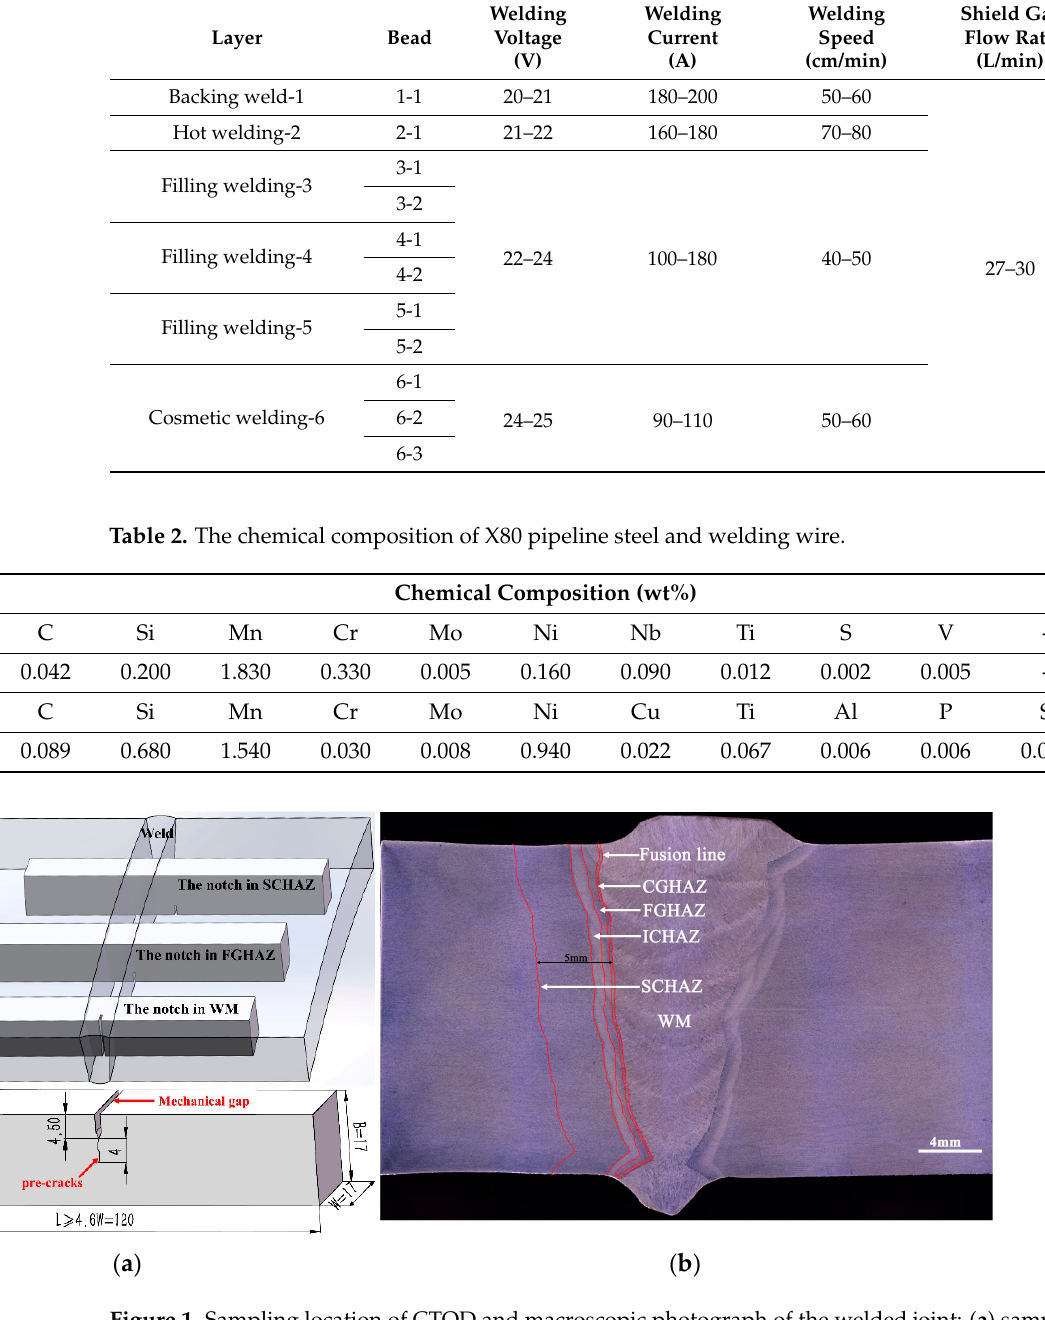
( c ) Figure 2. CTOD loading curve and statistical results of characteristic values: ( a ) CTOD loading curve of welded sample; ( b ) CTOD loading curve of PWHT sample; and ( c ) CTOD characteristic value statistics. 3.2. The Effect of Post-Weld Heat Treatment on Microstructure Evolution